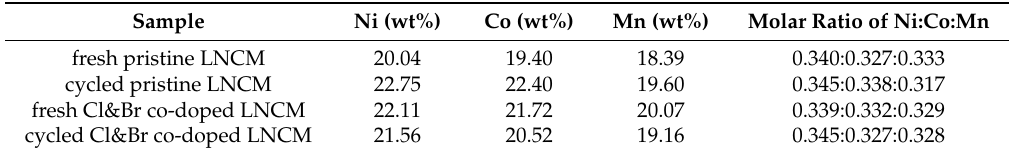
Table 1. Chemical composition (wt%) of the electrodes determined by energy dispersive spectroscopy (EDS) with the particles in Figure 6b,d,f,g.